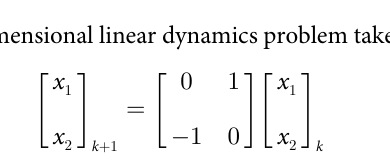
PLOS ONE | https://doi.org/10.1371/journal.pone.0256584 August 26,